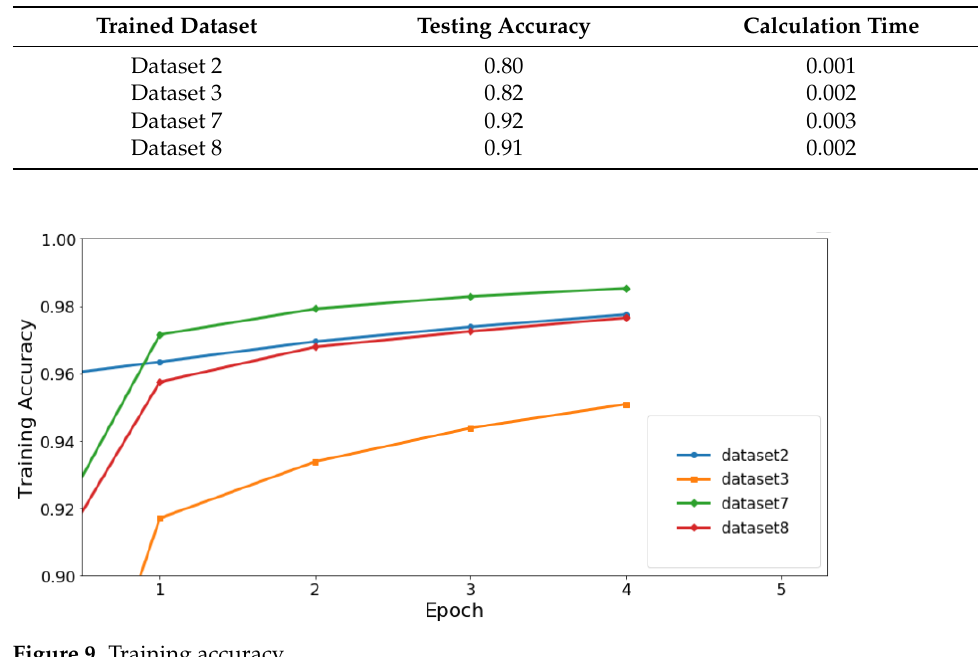
Figure 9. Training accuracy.